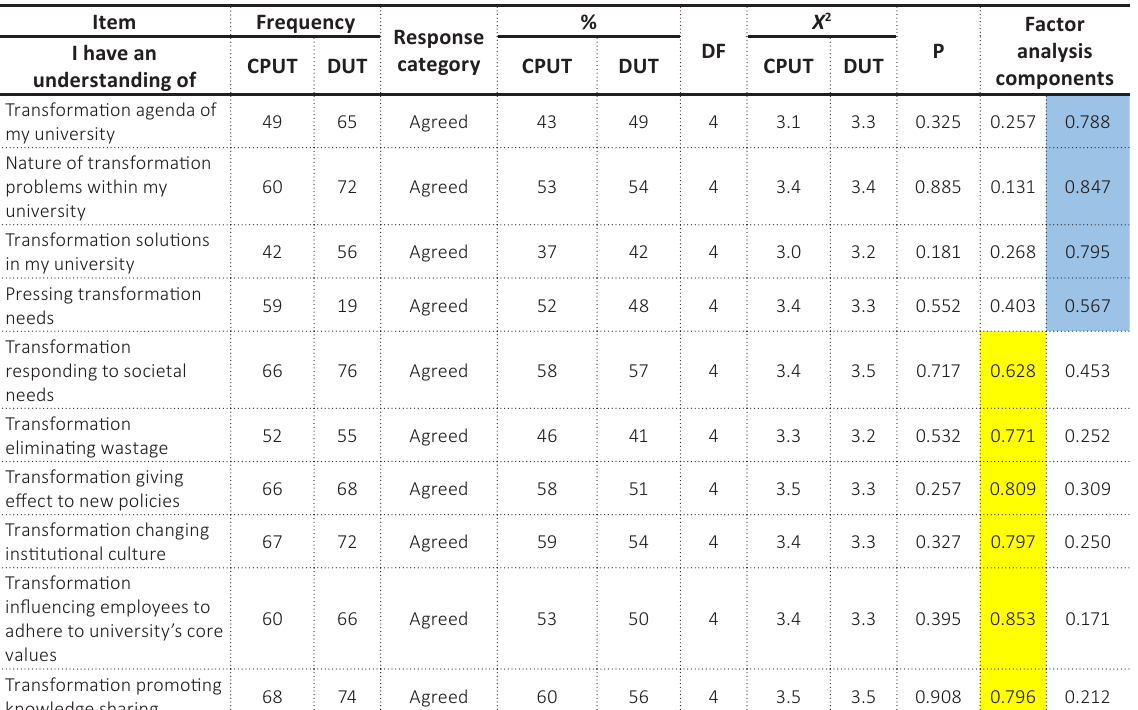
Table 3. The understanding of change in a